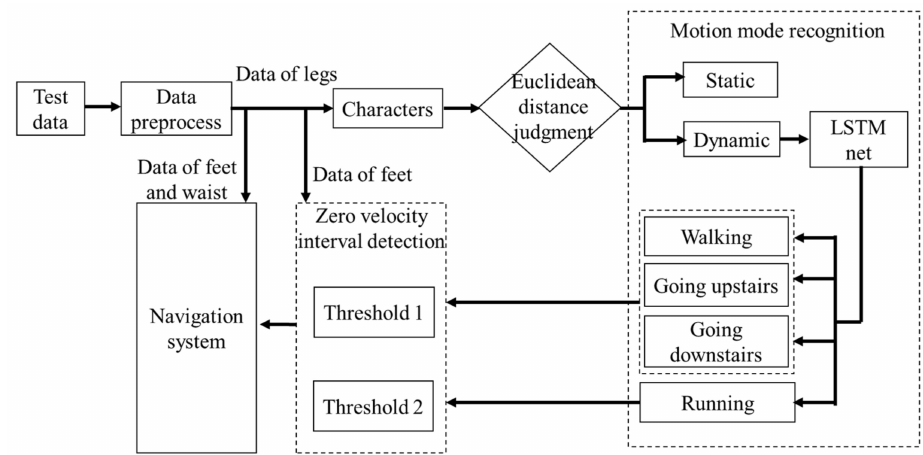
Figure 3. Scheme of the autonomous method for multi-motion modes recognition and zero-velocity detection for indoor